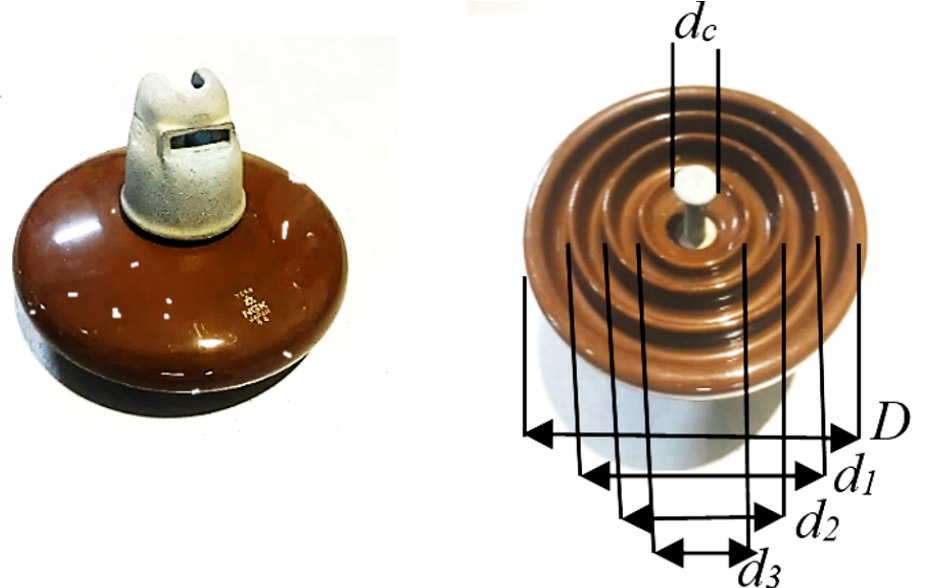
Figure 1. Insulator sample. Table 1. Test insulator structure characteristics.